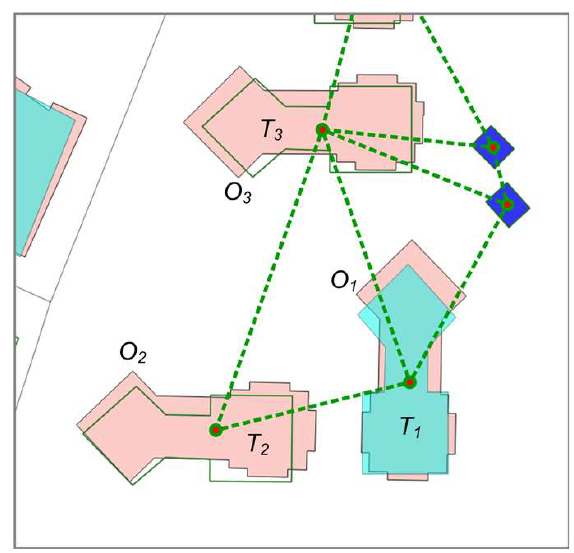
Figure 15. Potential use of contextual relations in correcting inconsistent results.